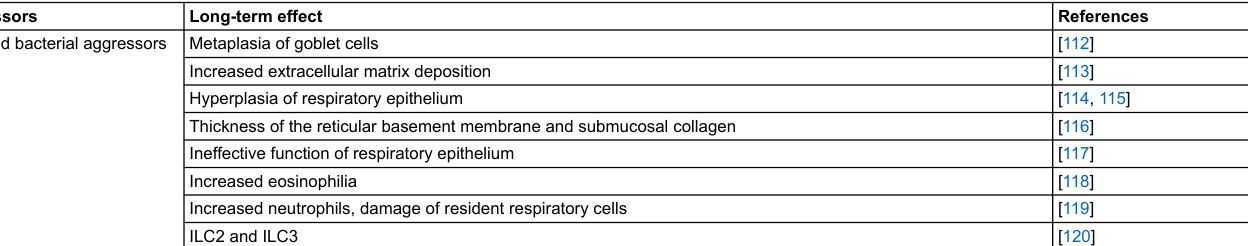
Table 4: Pathological responses of the airways leading to chronic asthma and long-term damage